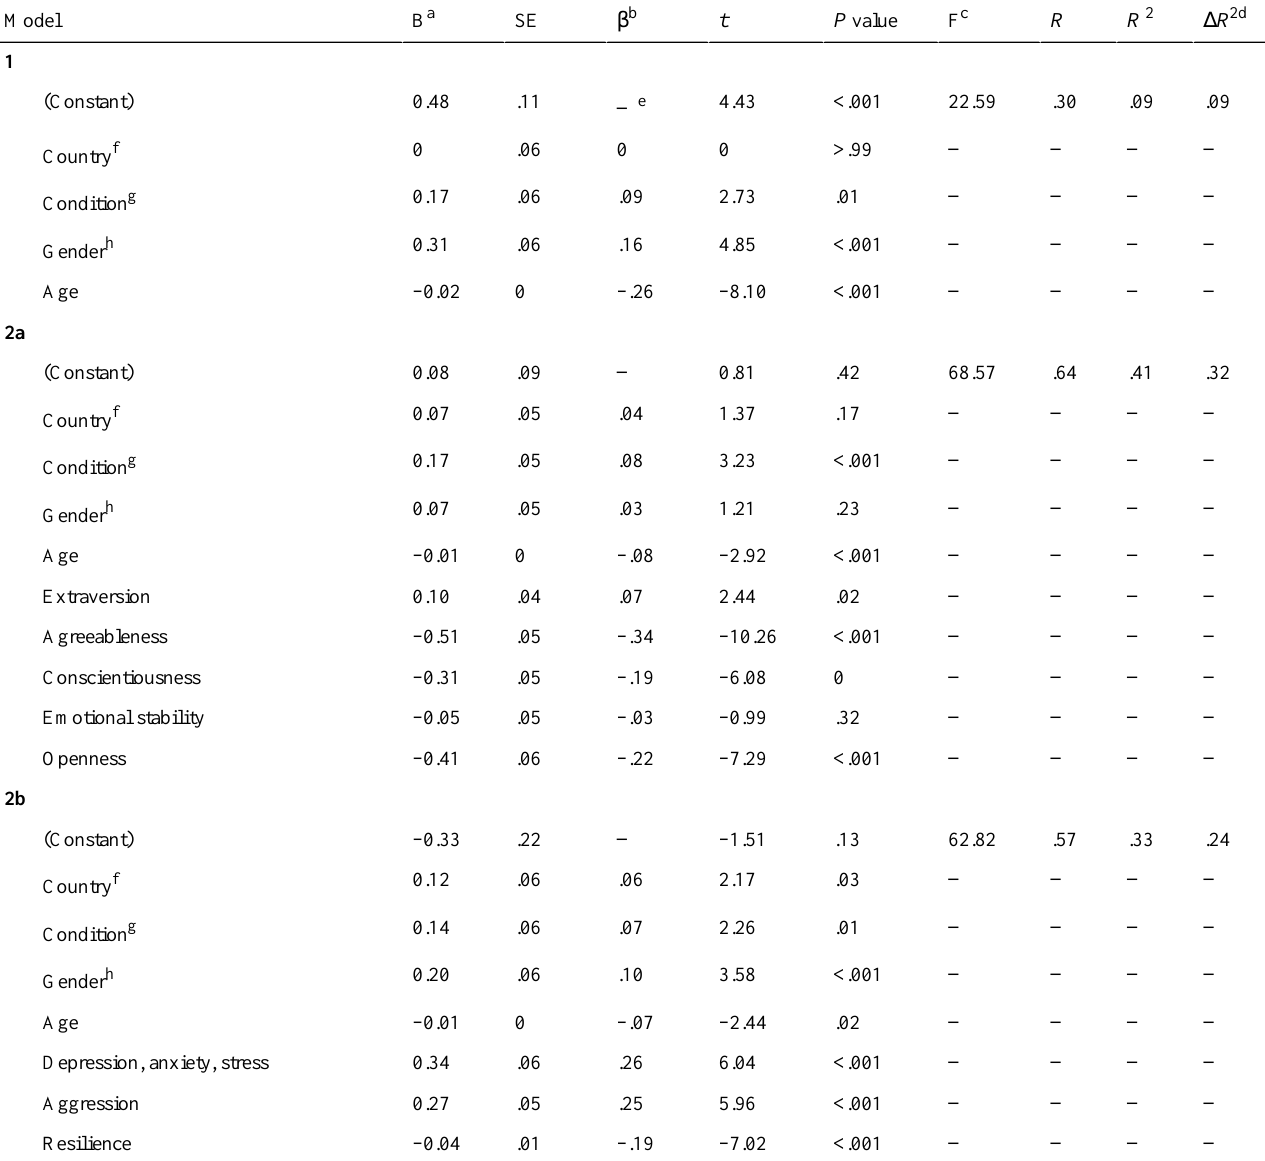
Table 4. Results of hierarchical regression analyses showing amount of variance in the proactive versus fight/flight reactions dimension accounted for by country of residence, condition, gender, age, Big Five personality traits, DASS-21, aggression, and